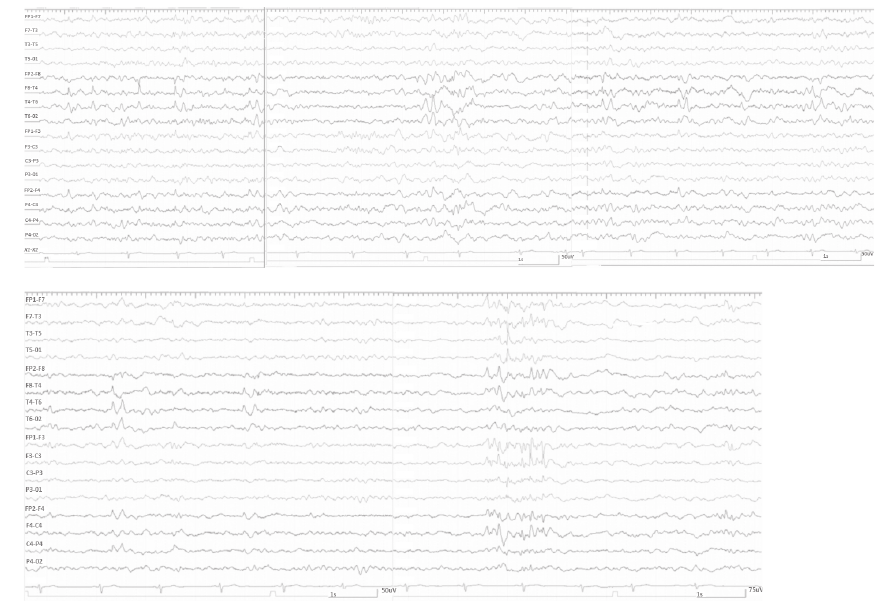
Figure 1: Interictal EEG pattern of the